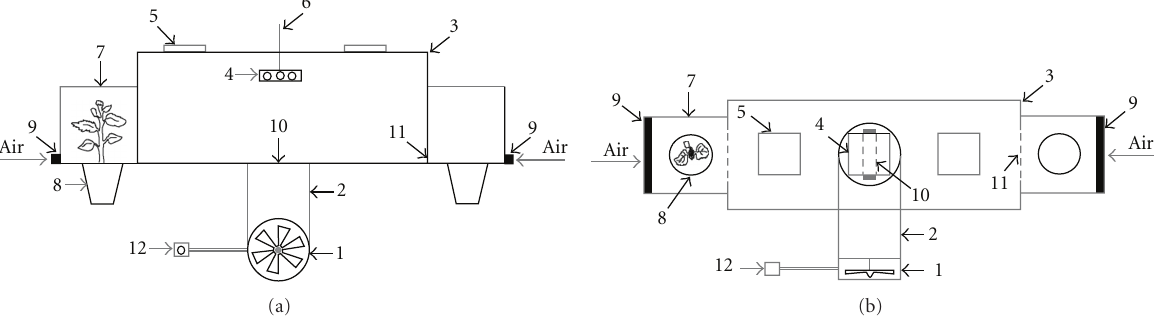
Figure 1: Diagram of the flat-bed wind tunnel used for testing plant volatiles. (a) Side view of the full length. (b) Top view. 1) Exhaust fan; 2) Cylindrical duct; 3) Wind tunnel chamber (transparent perpex); 4) Test insect holding box; 5) Doors for introduction and collection of insects; 6) Cord for pulling the insect box up; 7) Section for holding plant; 8) Potted desert plant; 9) activated charcoal filter; 10) wire mesh strip for air outlet; 11) wire mesh strip for air inlets; 12) Fan speed controller. Table 1: Comparison of overall means ( ± SE) frequencies of walking, scanning, and jumping per insect for locusts caught from field in presence and absence of host plant ( Heliotropium sp.) stimulus in photo- and scotophase. N = 80 insects used for each of the three behaviors. Behavioral activity (frequency of occurrence/insect) Scanning Jumping Walking Photophase Photophase